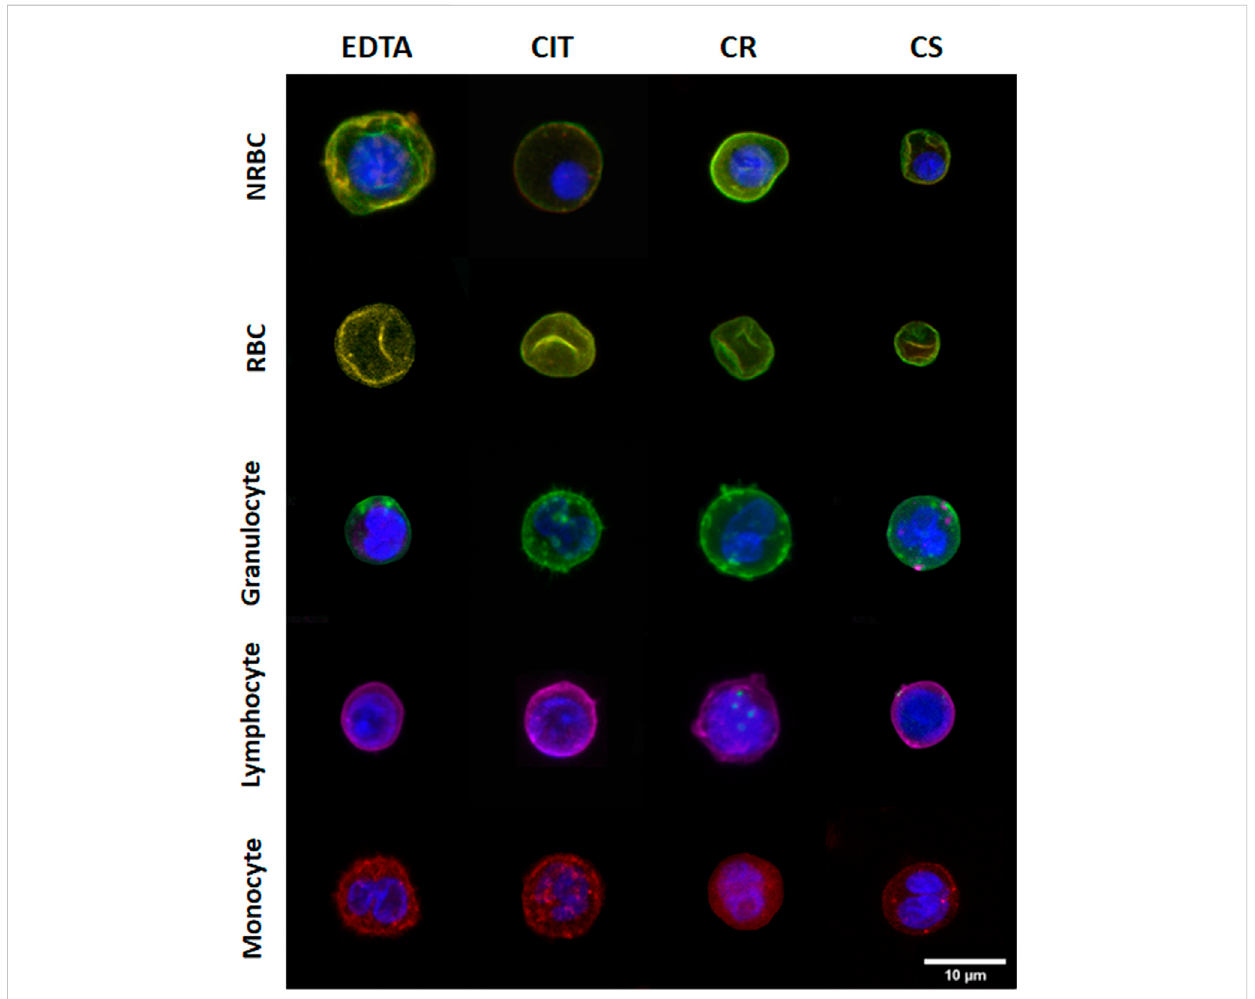
FIGURE 2 Representative 2D images of different cord blood cell groups collected in different conditions. The rows indicate the cell populations, and the columns indicate the collecting tubes.